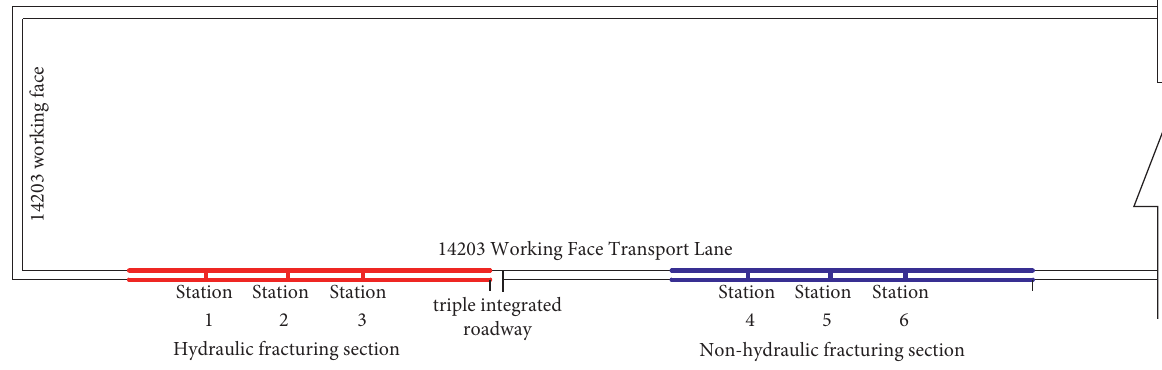
Figure 11: Hydraulic fracturing parameters of rubber haulage gateway